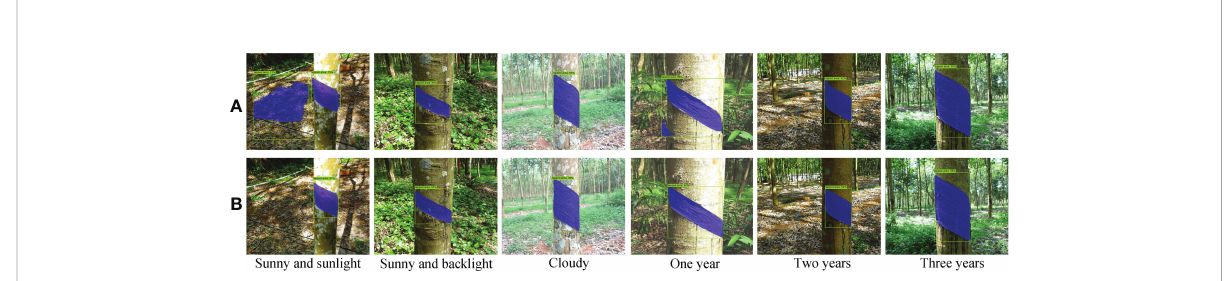
FIGURE 9 Tapped area detection and segmentation results of natural rubber trees of different models under different shooting conditions. (A) Mask RCNN. (B) Improved Mask